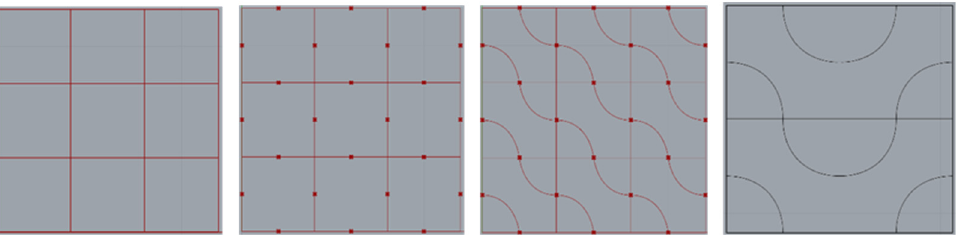
Figure 3. The resulting 3-D geometry was 300 percent upscaled and utilised for testing.